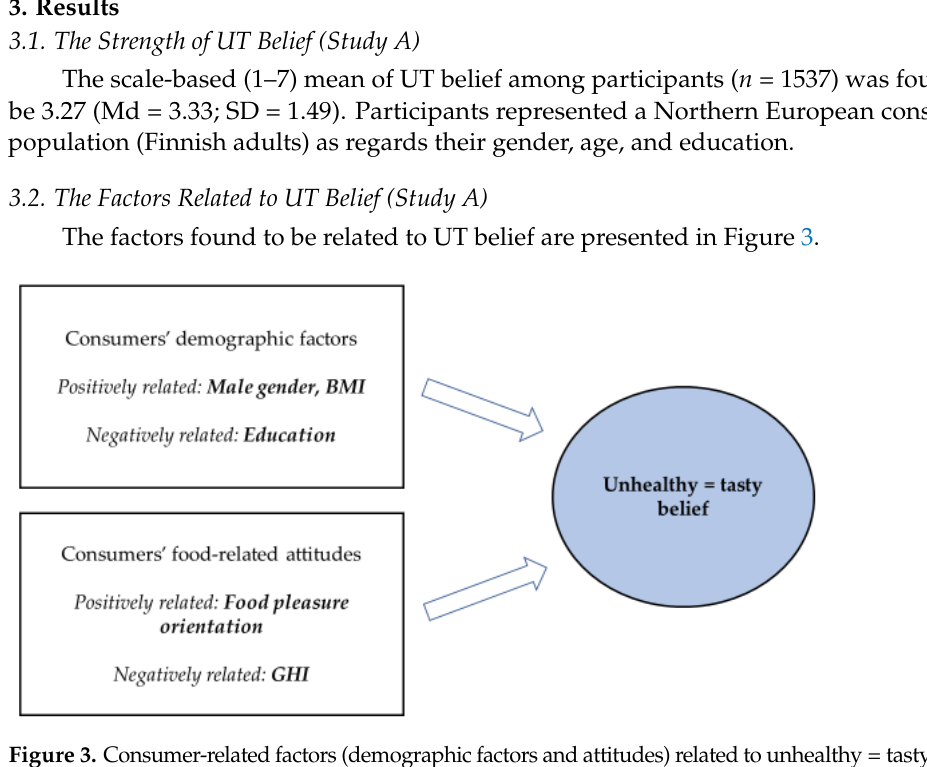
Figure 3. Consumer-related factors (demographic factors and attitudes) related to unhealthy = tasty belief.